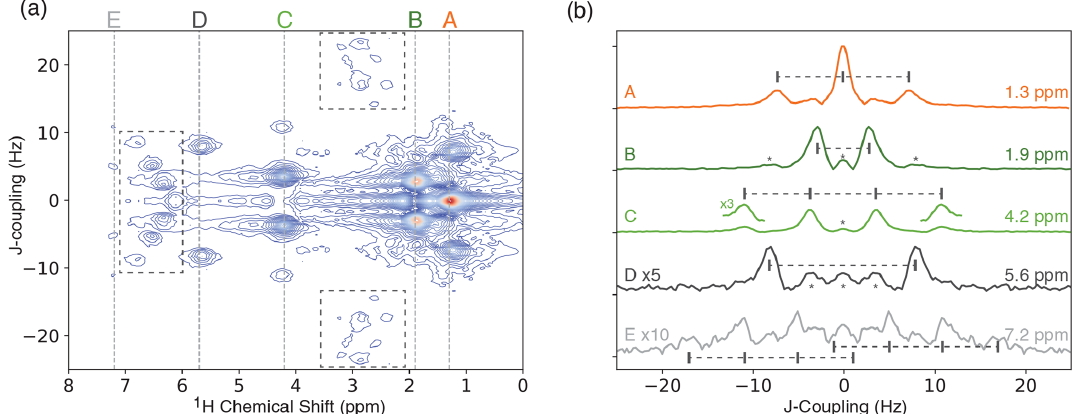
Figure 4. (a) ODNP-enhanced 1 H JRES spectrum of neat ethyl crotonate with 10mM TEMPONE. The dashed boxes indicate areas showing strong coupling effects. (b) Slices of JRES spectrum shown in panel (a) for each proton in ethyl crotonate. The expected multiplet pattern is indicated by vertical lines with corresponding tick marks. Spectra are offset for clarity. Features marked with an asterisk are artifacts of the JRES experiment.